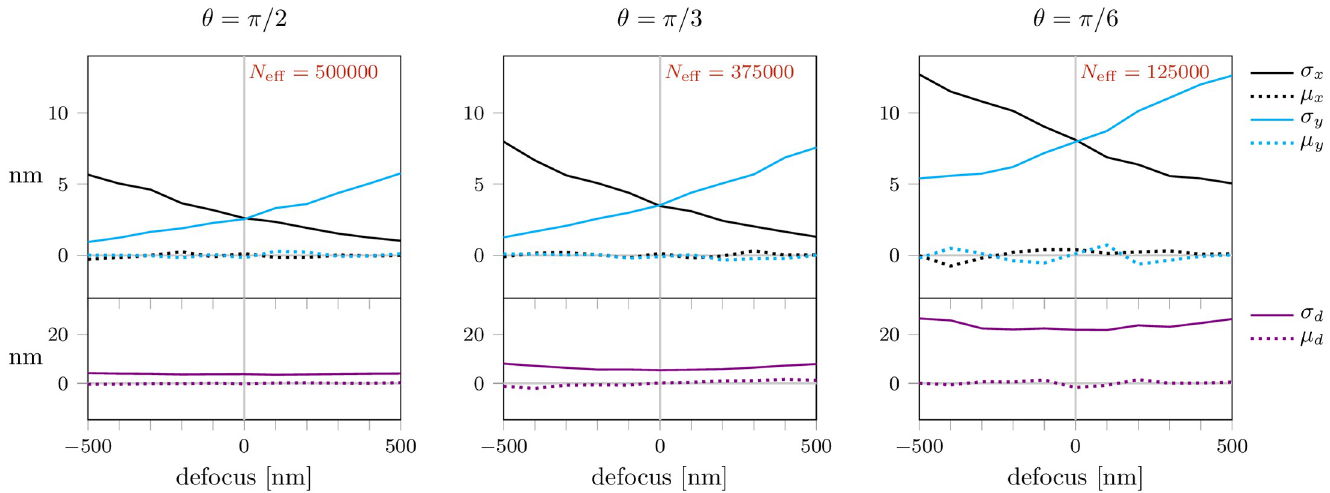
Fig 8. Combined effect of reduced excitation probability of tilted dipoles, and uncertainties in dipole orientation. We accounted both for reduced excitation probability of tilted dipoles as well as errors in the determination of dipole orientations; for the latter we assumed a normal distribution with a standard deviation of 2˚ both for θ and ϕ as in Fig 7. A list of all simulation parameters is given in S1 Table in S1 File.